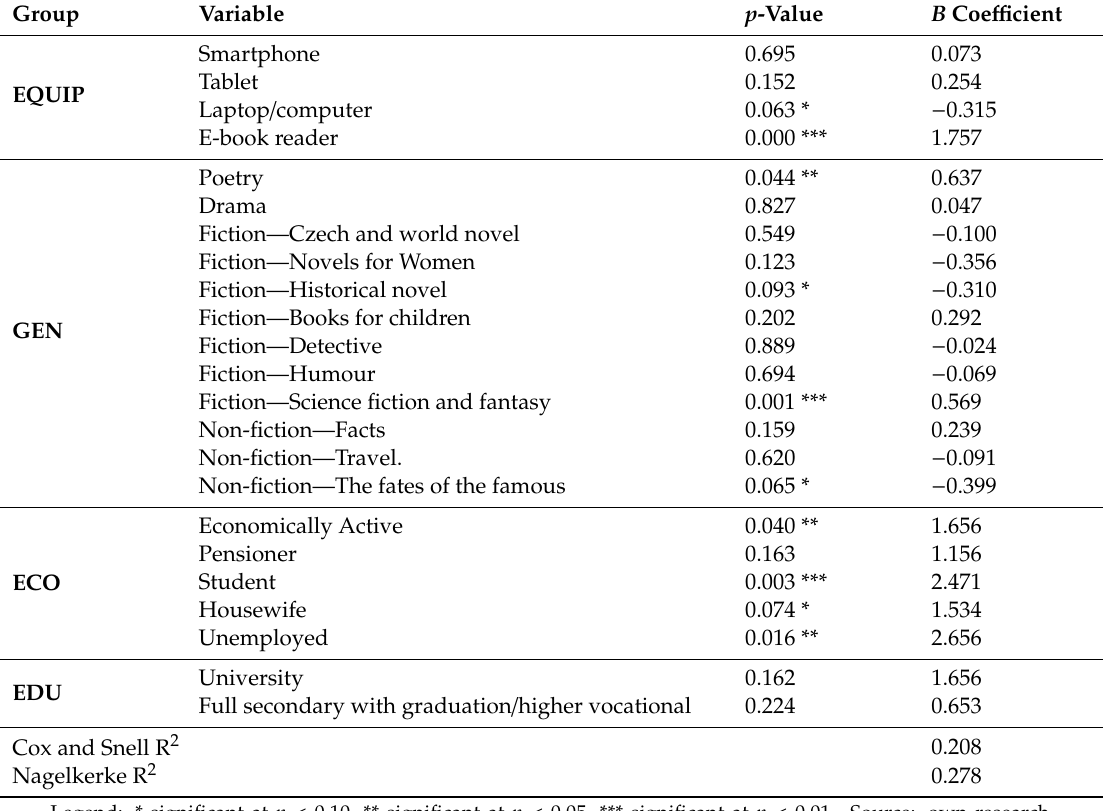
Table 3. Analysis willingness to read e-books: target